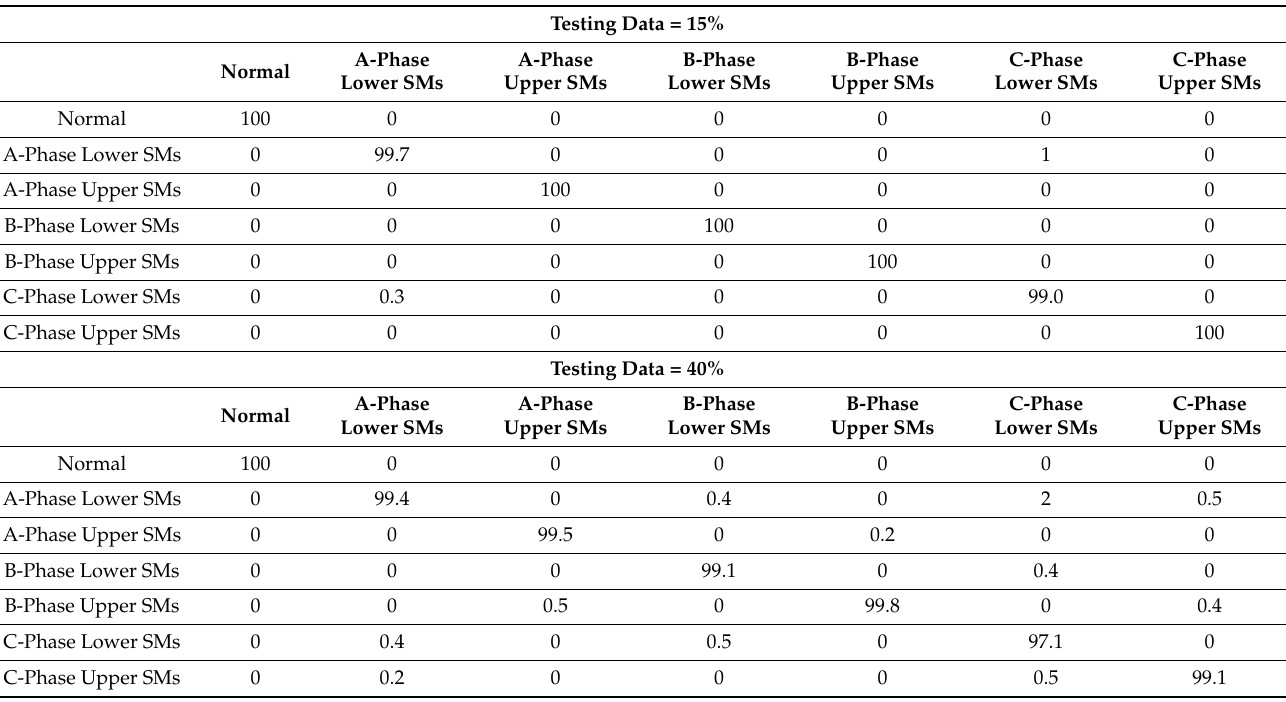
Table 7. Sample confusion matrix of the classification results of MLR-based with data